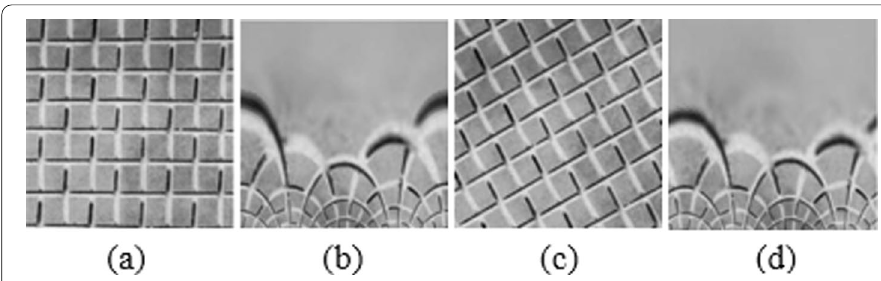
Fig. 2 Results after Log‑polar Transform. a Original image, b image after LPT, c image after rotating 30°, d image after rotating 30°and